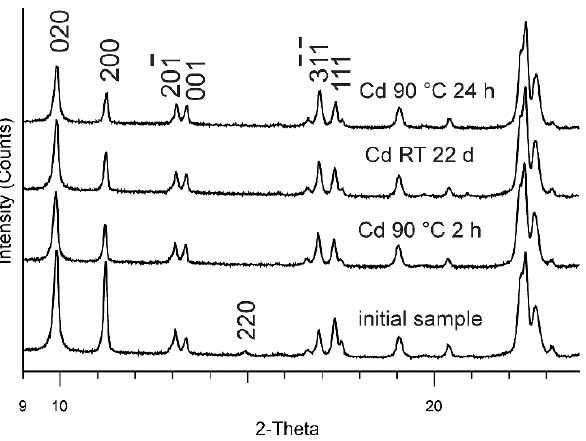
Figure 2. Selected powder XRD patterns of Cd-exchanged clinoptlolite.